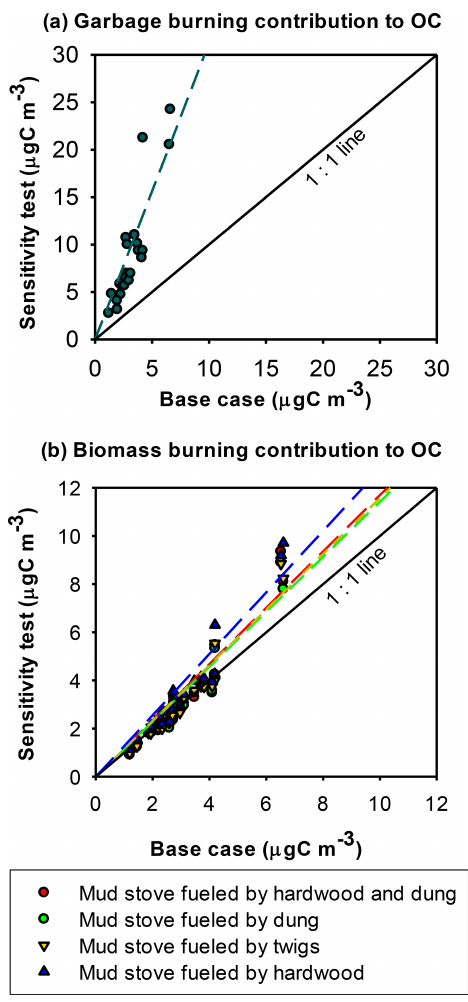
Figure 6. Sensitivity of CMB model results to the input source pro- files: (a) sensitivity of garbage burning contributions to PM 2 . 5 OC to the garbage burning profile and (b) sensitivity of biomass burning contributions to PM 2 . 5 OC to biomass burning